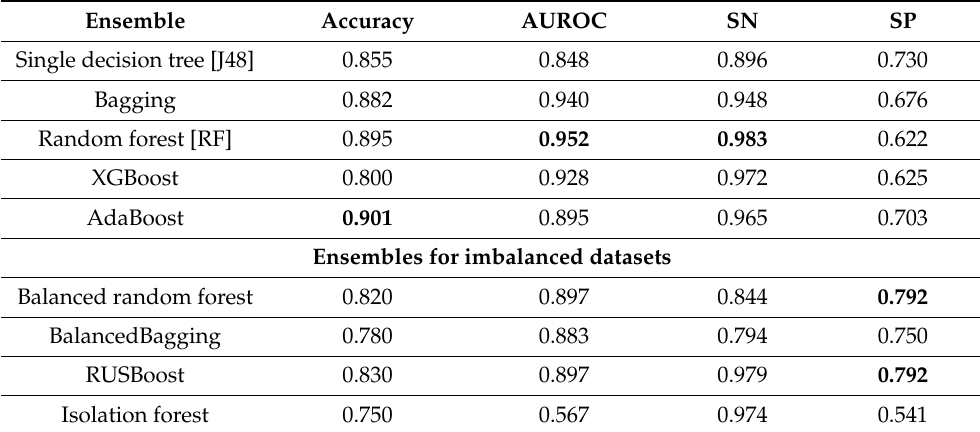
Table 3. The comparative study of different ensemble classifiers. Various types of performance metrics are used to measure ensembles performance. (Best results are shown in bold numbers).